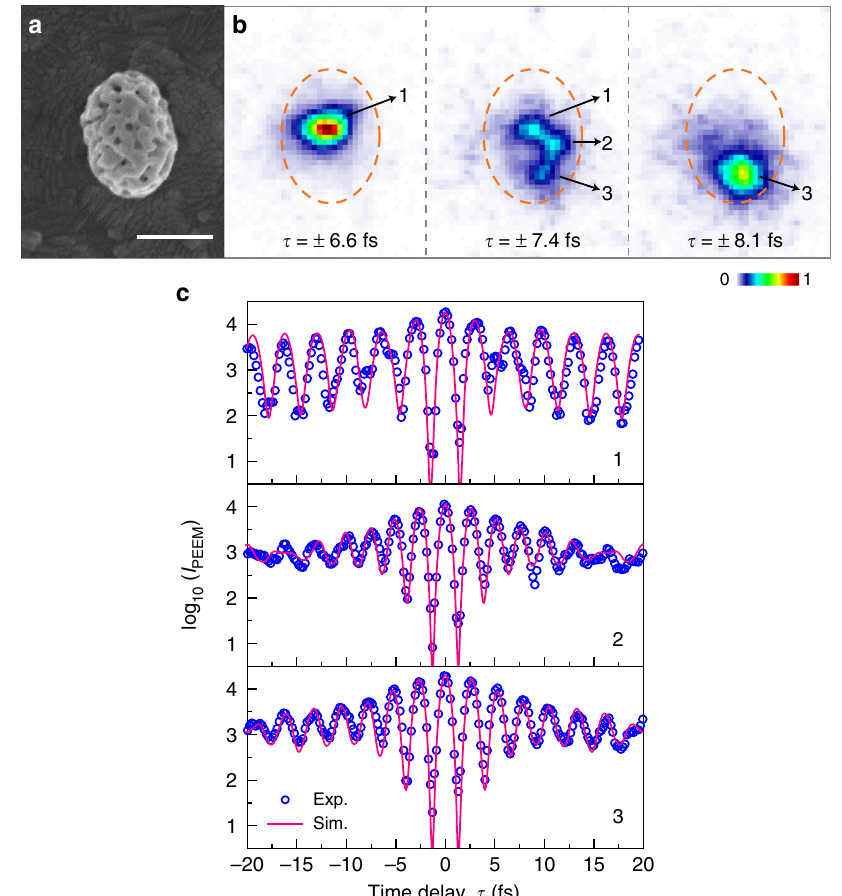
Fig. 2 Interferometric time-resolved photoelectron emission from individual hot spots of a single gold nanosponge. a Scanning electron microscopy image of a single gold nanosponge, scale bar: 300 nm. b Photoemission electron microscopy images of the nanosponge with its contour indicated by dashed ellipses, recorded at different time delay τ of the few-cycle pulse pair. Electron emission from three well-de fi ned localized plasmonic hot spots is observed, which can be selectively excited by tuning τ . c Experimental (blue circles) and simulated (pink lines) interferometric autocorrelation traces of the electron emission intensity at the three hot spots. Each localized hot spot is modeled as a Lorentzian oscillator that is excited by the laser pulses and a n th- order ( n = 2.5 − 3) nonlinear photoemission process is assumed. For each hot spot, the local fi eld is given as the superposition between the hot spot fi eld and a short-lived (dephasing time T 2,dp = 3 fs) dipole mode fi eld, delocalized over the nanosponge 22 . The fi tting gives the following parameters: resonance = 2.02, 2.48, and 2.37 fs − 1 , dephasing times T = 17, 10, and 13 fs, order of nonlinearity n = 3, 2.5, and 2.7, for hot spots 1 – 3, frequencies ω j 2, j P ; j